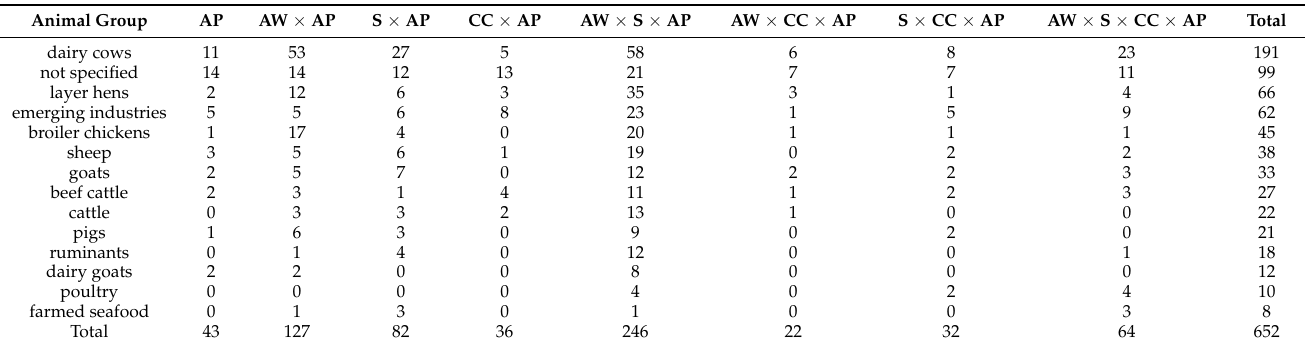
Table 5. Summary of articles discussing Animal Production (AP) interaction with Animal Welfare—AW, Climate Change— CC, Stress (S) in their research between 2015–2021.